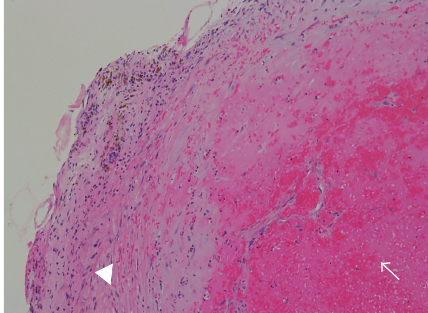
Figure 3: Photomicrograph, hematoxylin and eosin stain, display- ing a fibrocollagenous aneurysm wall with hemosiderin deposition (arrowhead) and intraluminal fibrin clot with early organization